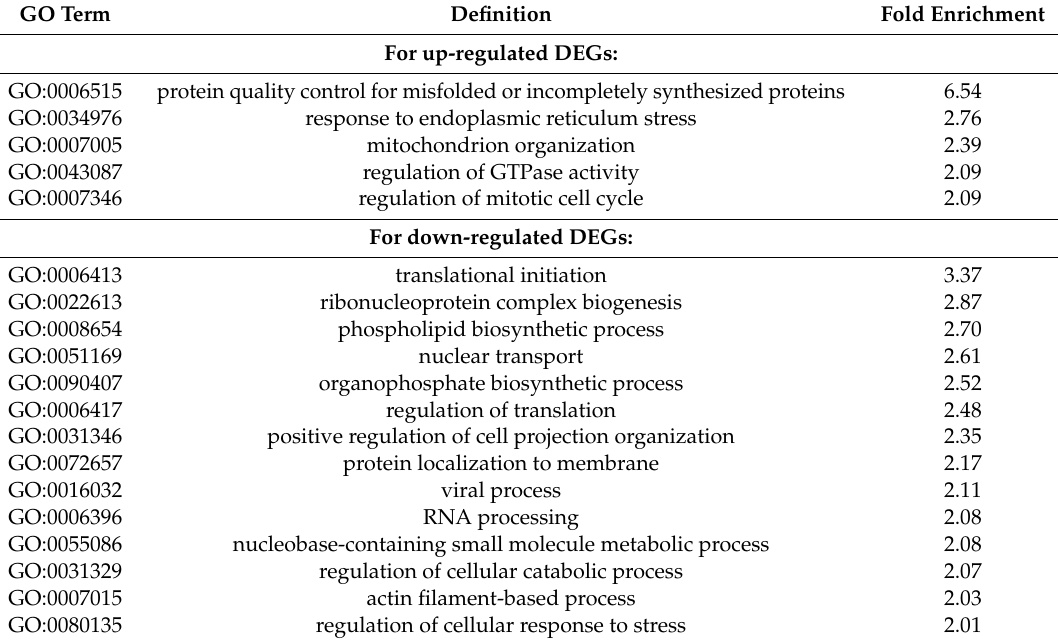
Table 1. GO enrichment analysis data for DEGs found with eL29-knocked down HEK293 cells 1